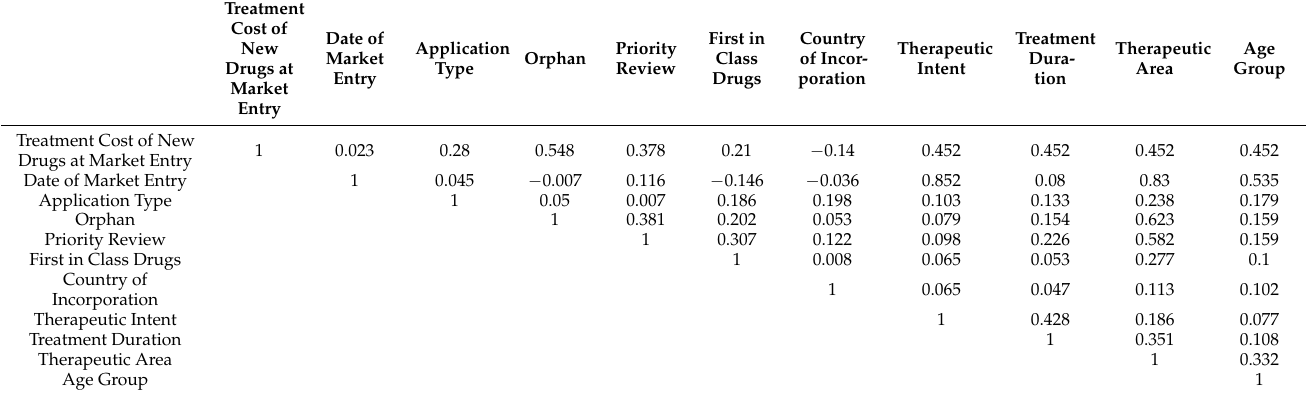
Table A2. Correlation